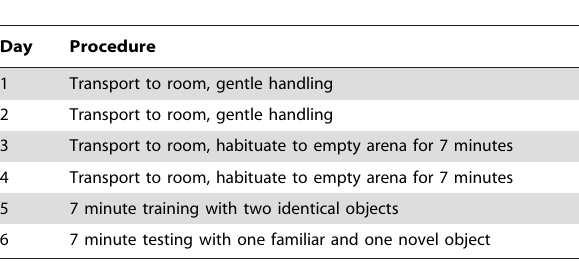
Table 1. Novel Object Recognition